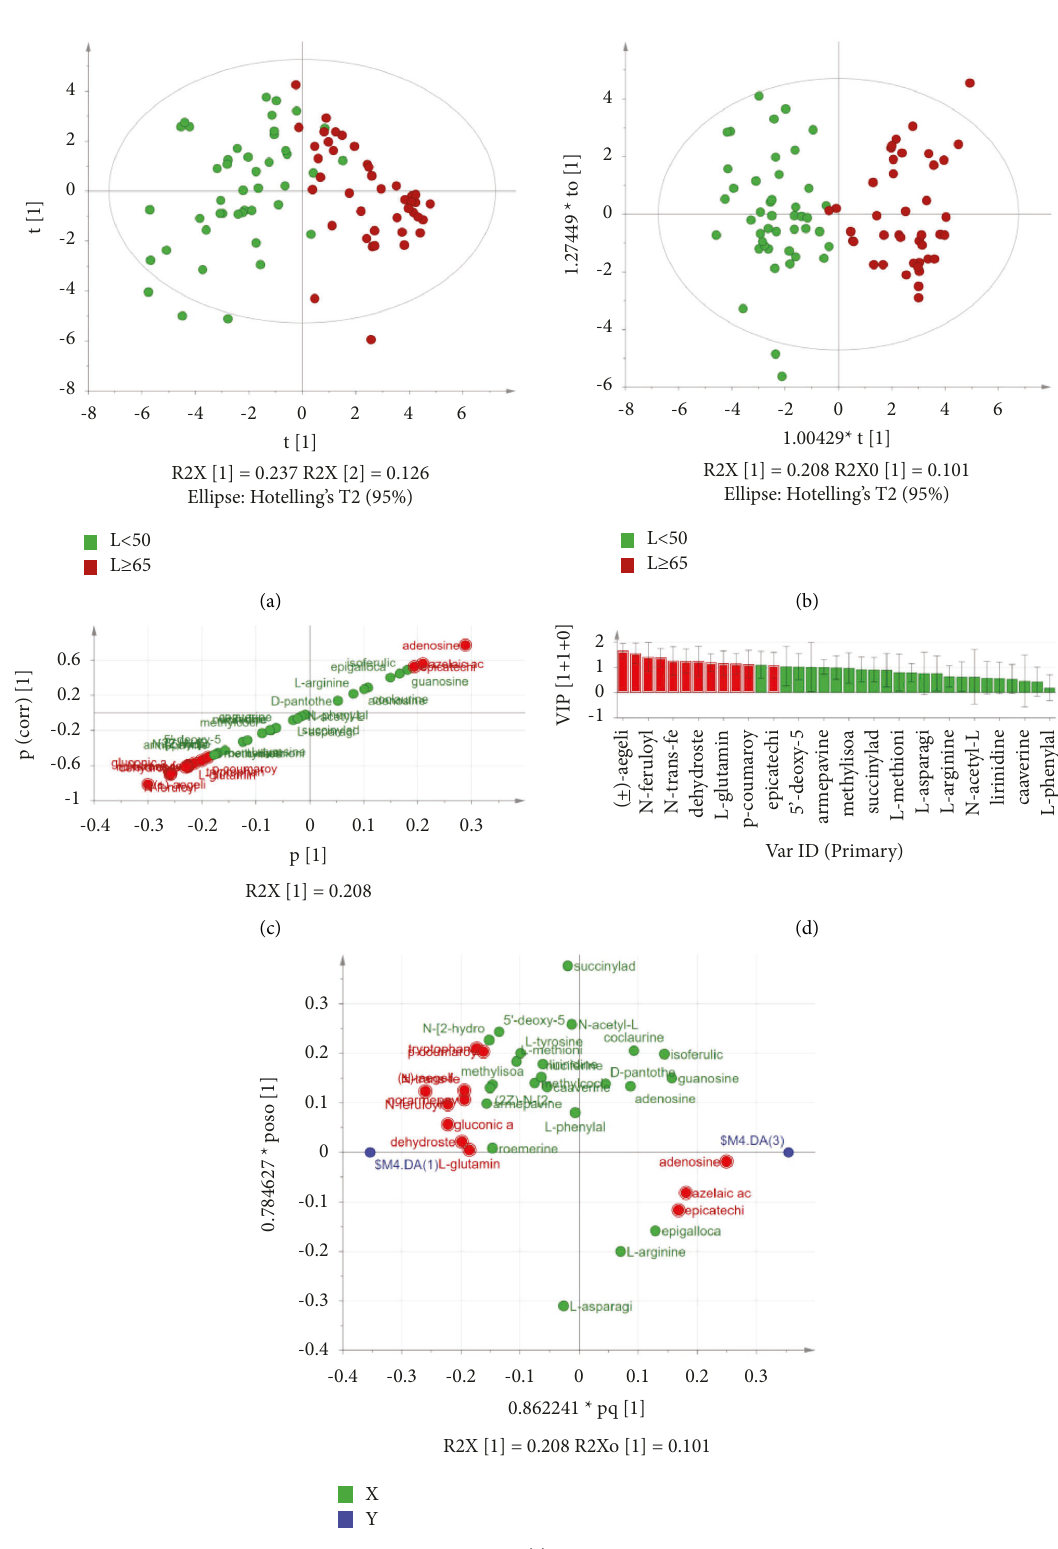
Figure 3: Relationship between targeted secondary metabolites (polyphenols, amino acids, and alkaloids) and their morphological variations (browning and size) in 212 sacred lotus rhizome cultivars (significant compounds are shown in red). (a) PCA of 212 sacred lotus rhizomes with different morphological variations. (b) OPLS-DA of 212 sacred lotus rhizomes with different morphological variations. (c) S- plots of secondary metabolites constructed using OPLS-DA analysis. (d) VIP distribution of the 48 identified and quantified